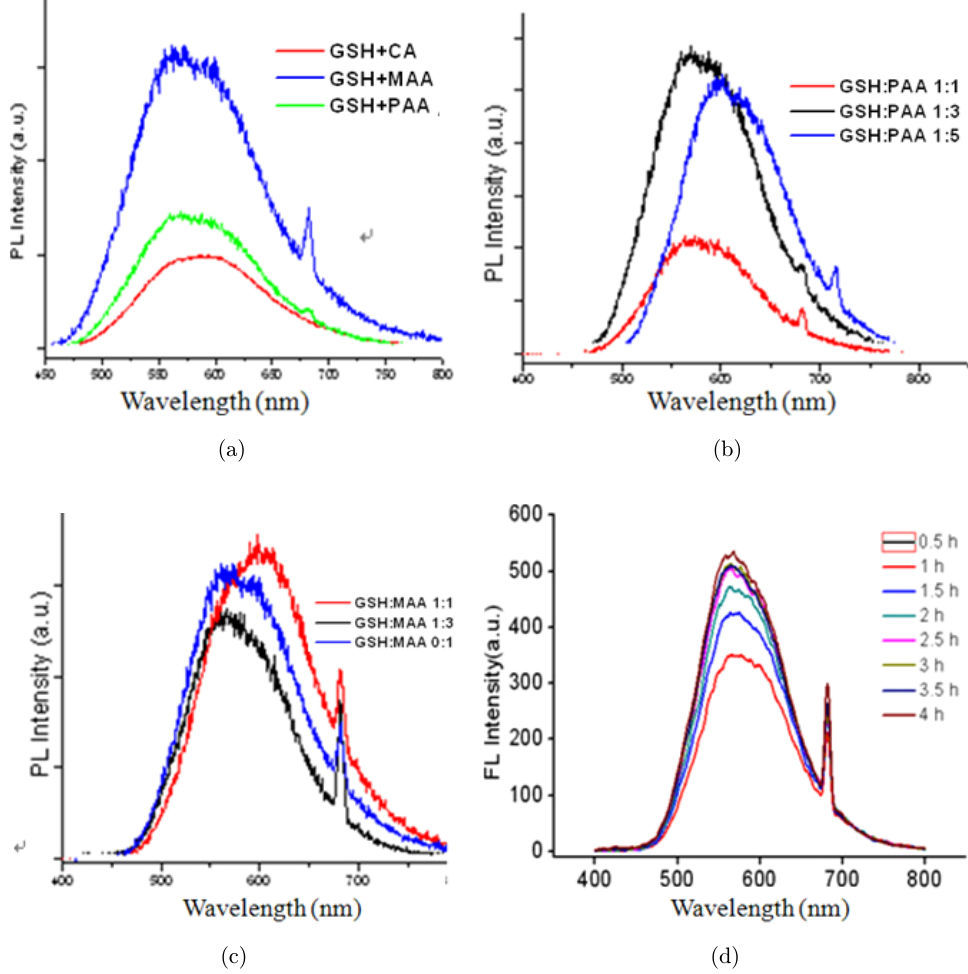
Fig. 1. PL spectra of the prepared water-soluble ZAIS